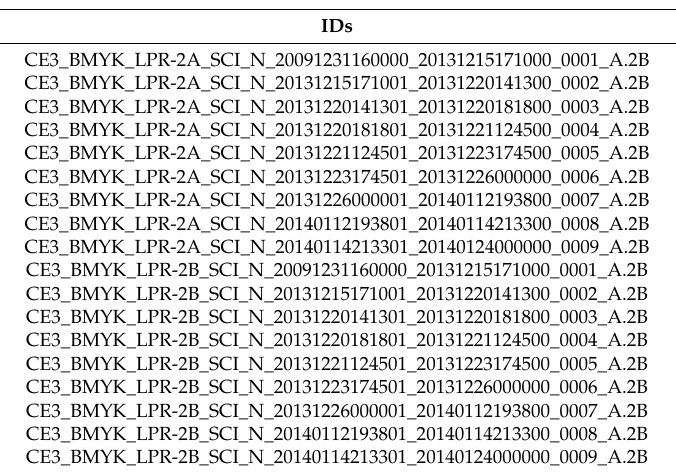
Table A1. IDs of the LPR